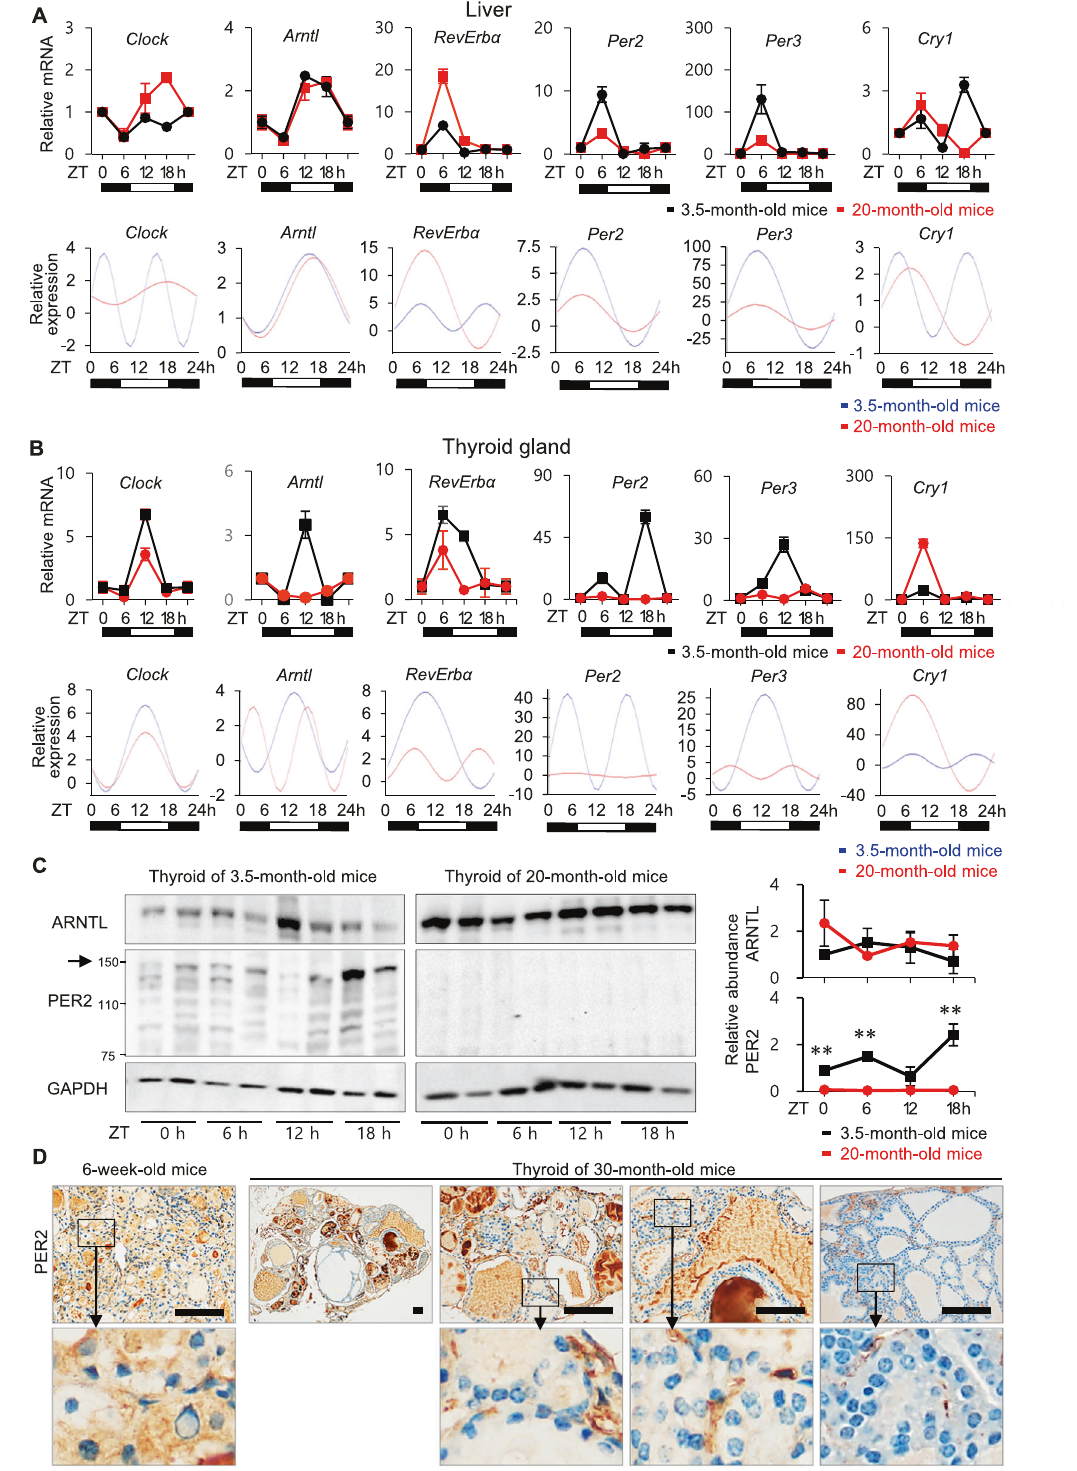
changed by PER2 depletion in Nthy-ori 3.1 or TPC1 cells. There were no signi fi cant differences in phosphorylation of AKT or p70S6 kinase (Fig. 5A). These results suggested that PER2 depletion in thyroid follicular cells induced activation of the AP- 1 transcription factor c-Fos via JNK MAPK